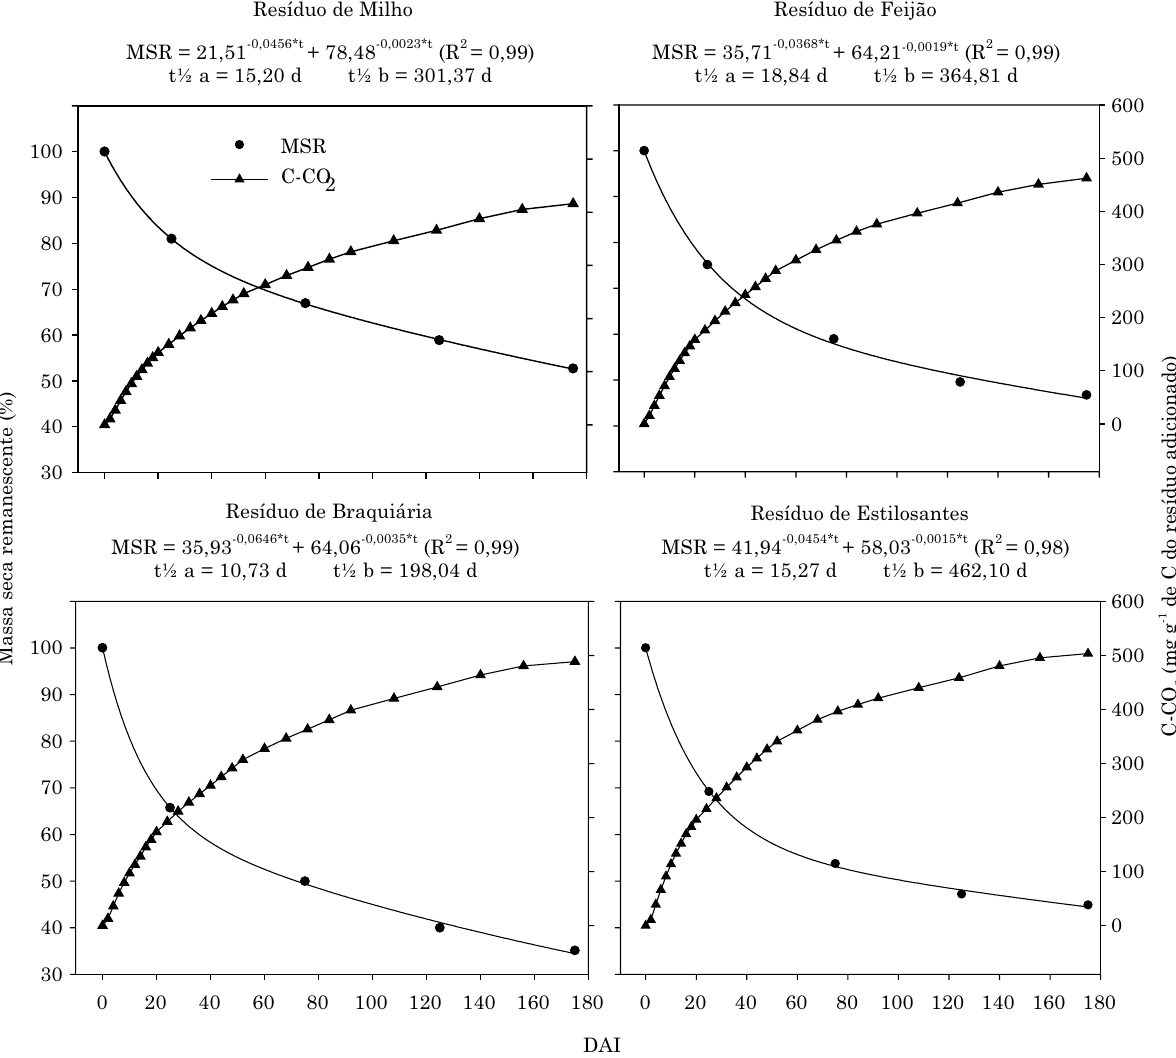
figura 1. c-co 2 líquido acumulado e massa seca remanescente (msR) dos resíduos em razão dos dias após o início da incubação (Dai), com os respectivos tempos de meia-vida (t½), do compartimento facilmente decomponível (t½ a) e do recalcitrante (t½